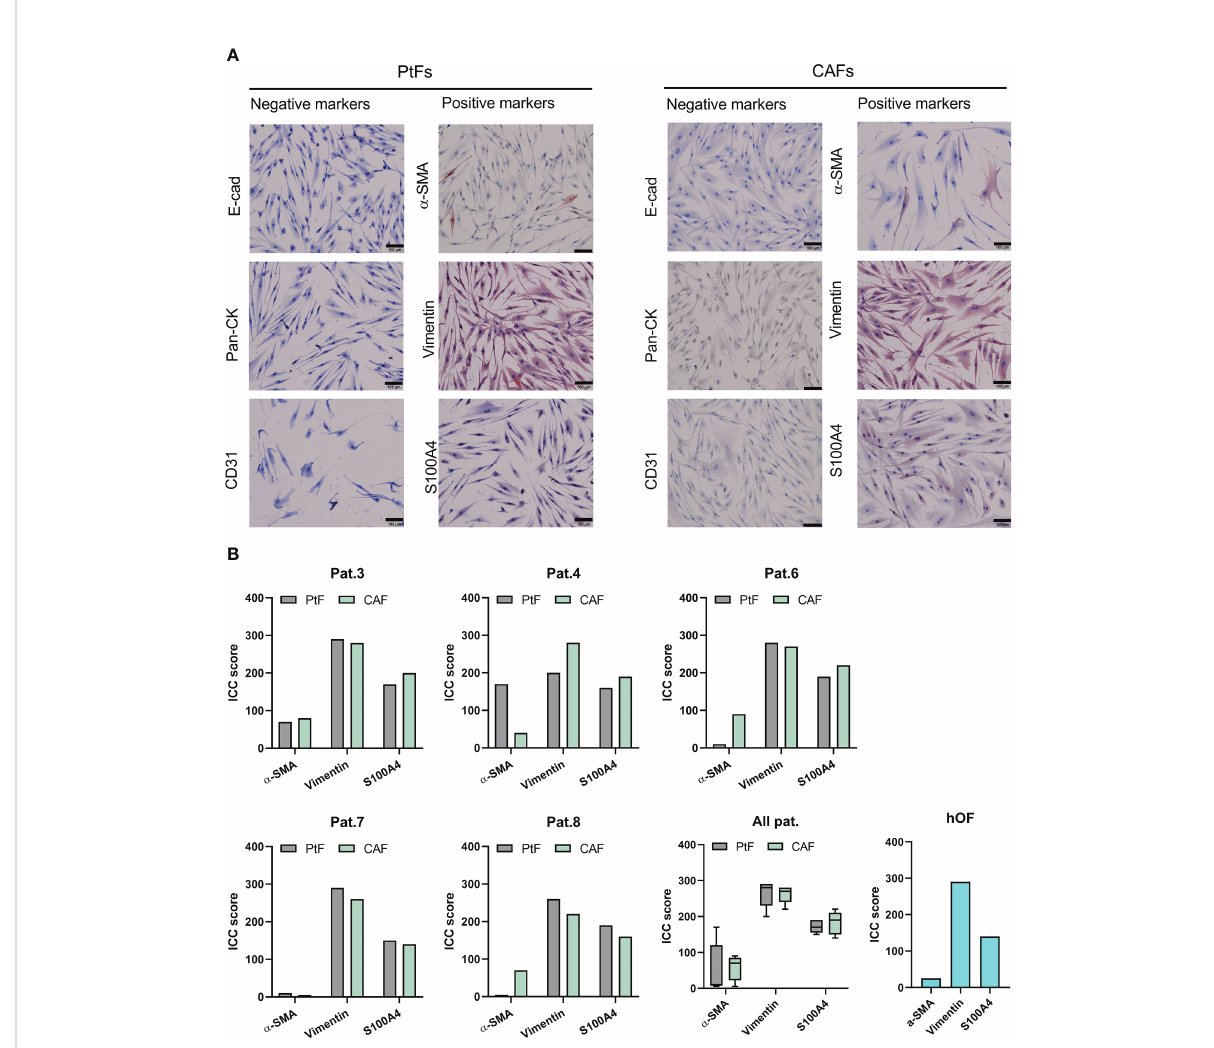
FIGURE 2 Immunocytochemistry (ICC)-based characterization of PtFs and CAFs. (A) Expression of epithelial markers [E-cadherin, pan-cytokeratin (Pan- CK)], endothelial marker (CD31), and the fi broblast markers ( a -SMA, Vimentin, S100A4) in PtFs and CAFs was assessed through ICC staining and counter staining with hematoxylin-eosin during passages 1-2. Representative images are shown. (B) ICC scoring was performed on fi broblast markers of individual patients (Pat.3, Pat.4, Pat.6, Pat.7 and Pat.8), all patients combined, and human oral fi broblast (hOF; bottom